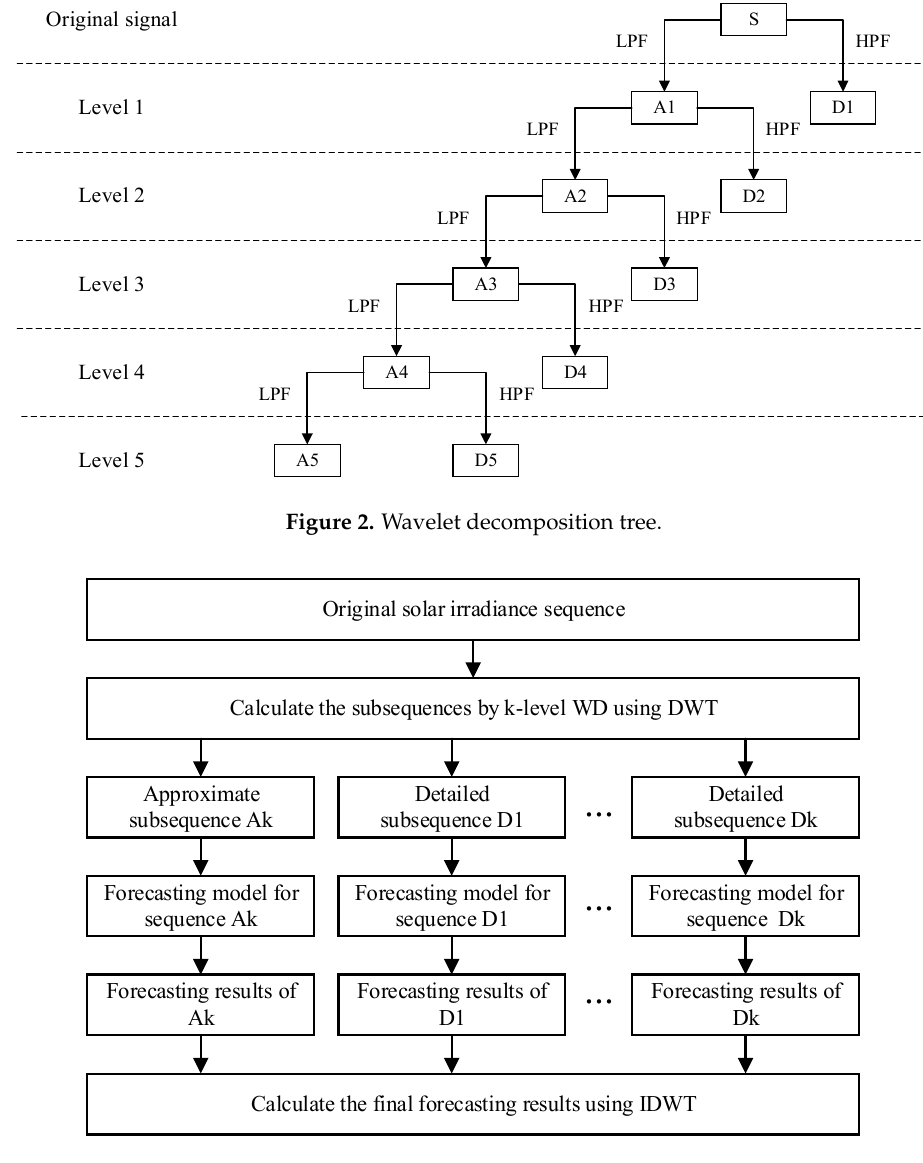
Figure 3. The k-level wavelet decomposition (WD) based solar irradiance forecasting method.